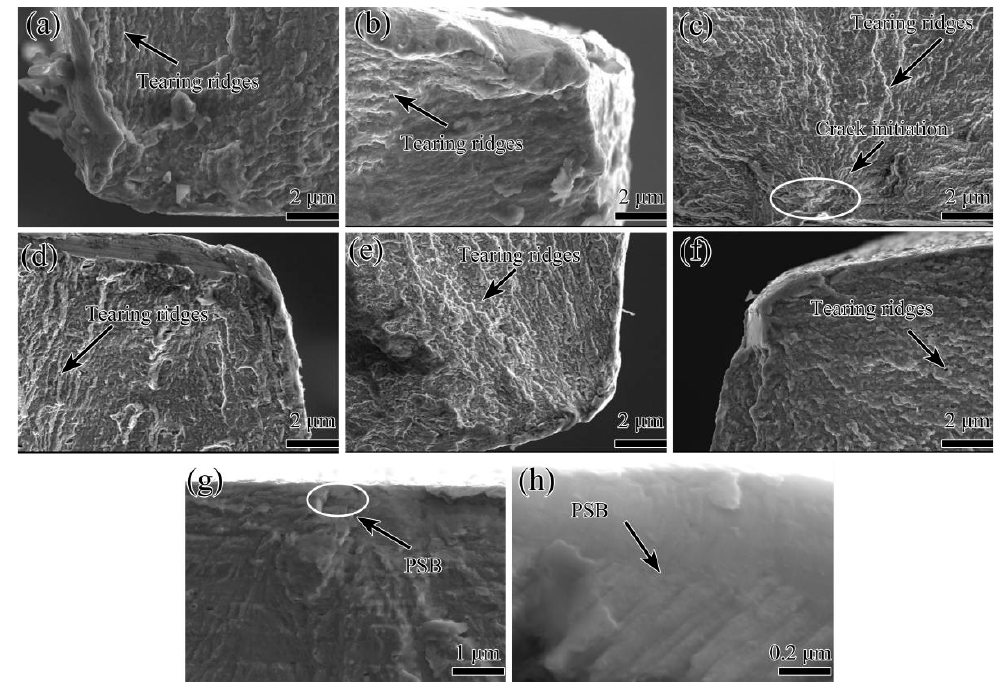
Figure 9. Scanning electron microscopy (SEM) images of fatigue fracture initiation in annealed 7005 aluminum alloy plates subjected to different pre-tensile deformations: ( a ) 3%, ( b ) 5%, ( c ) 8%, ( d ) 12%, ( e ) 16%, and ( f ) 20%, ( g ) PSB in 20% pre-stretched alloy plate, ( h ) local enlarged image of the circle zone in ( g ).